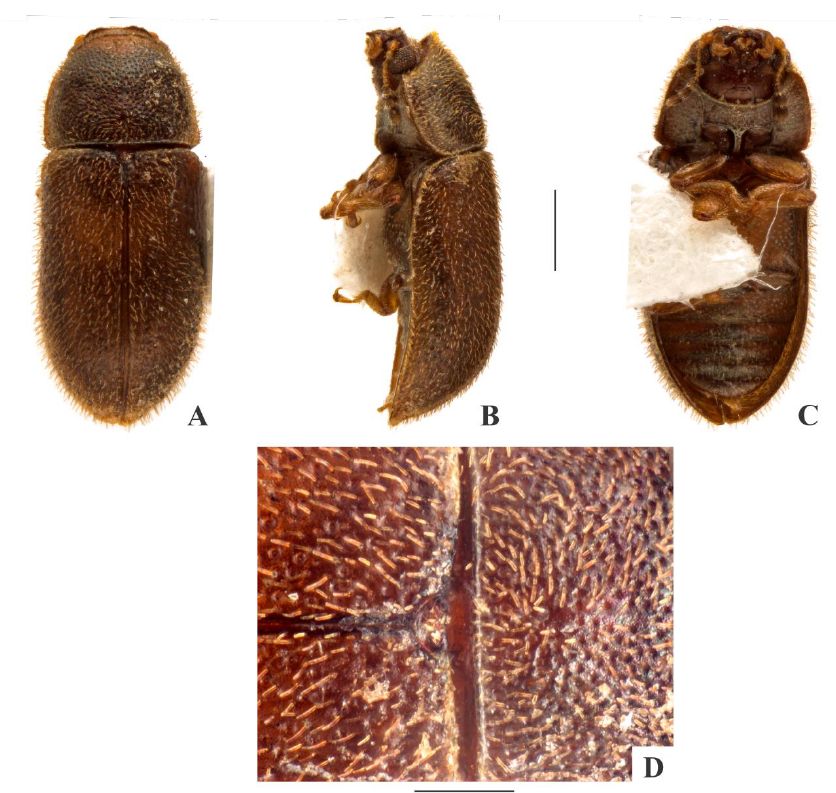
Figure 3. Cis fuscipes Mellié, 1849, female ( A – D ): A. Dorsal view. B. Lateral view. C. Ventral view. D. Scutellar shield and part of the pronotum and elytra. Scale bars: 0.5 mm ( A – C ), 0.2 mm ( D ). Diagnosis: The species belongs to the fuscipes group. It differs from C. capensis in males bearing truncate or weakly convex anterocephalic edge and anterior pronotal edge rounded, but only female C. fuscipes have been recorded from southern Africa. It differs from females of C. capensis in the anteriormost portion of head visible when see from above.